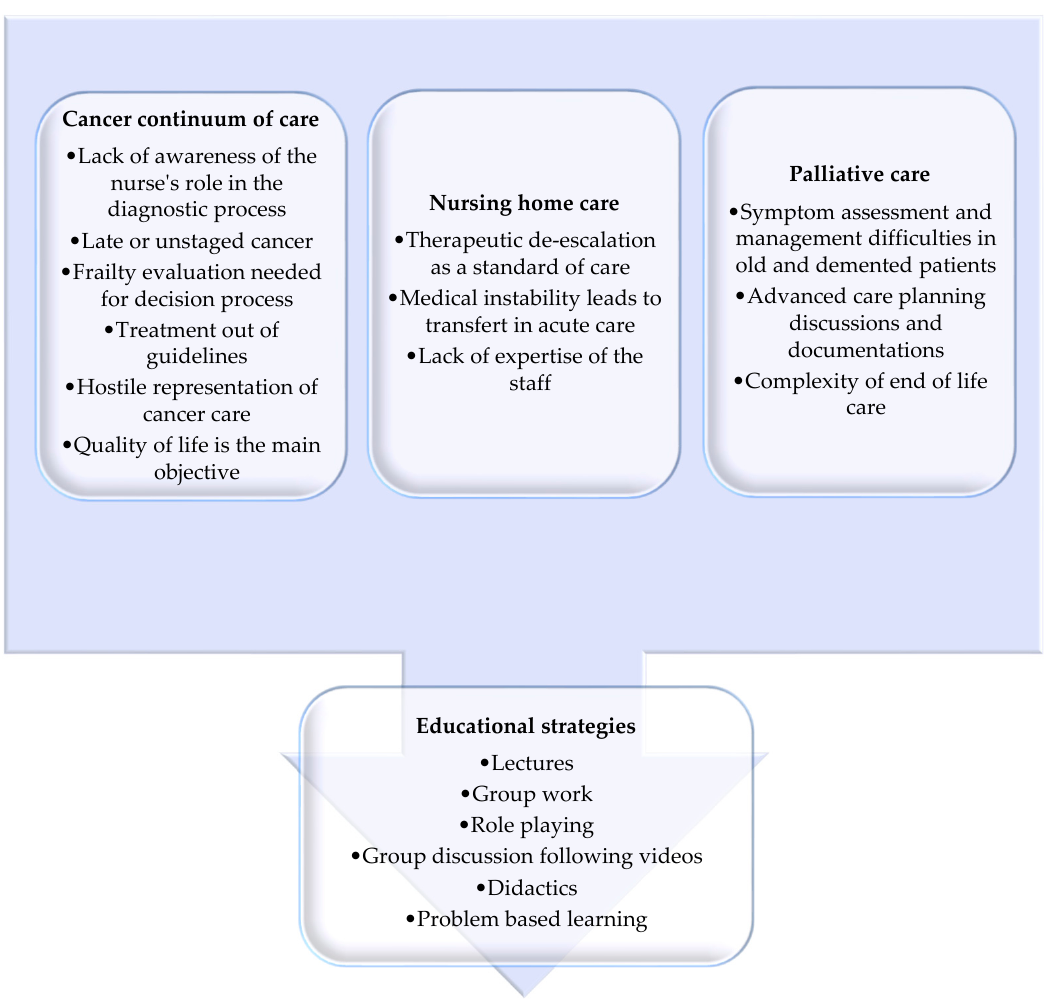
Figure 2. Main barriers of cancer treatment in nursing homes divided in cancer continuum of care, palliative care, and nursing home care, as well as the solutions represented by educational strategies.